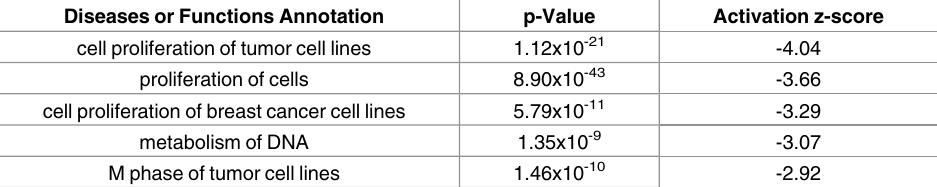
Table 1. Diseasesand Functions Predicted to be Inhibited by TGF- β